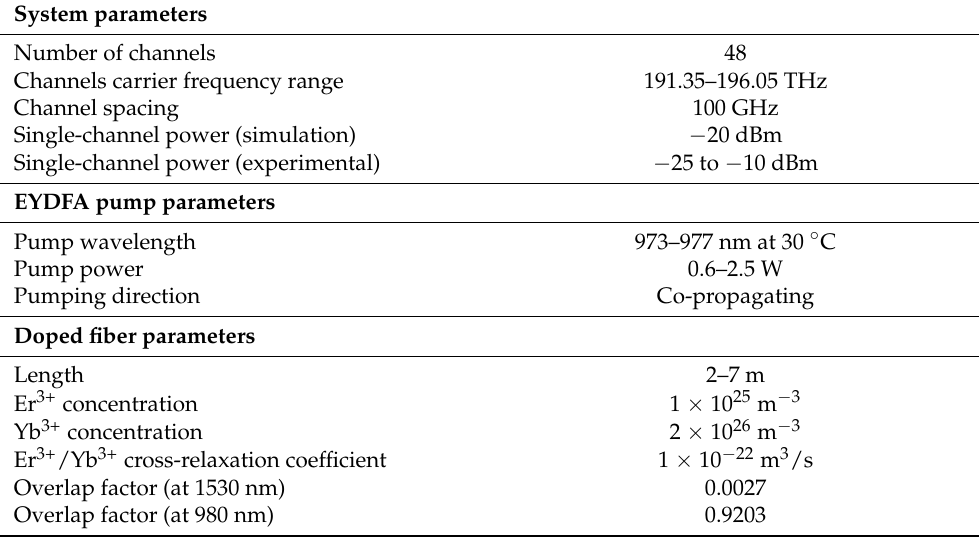
Figure 6. Simplified experimental setup of the cladding-pumped EYDFA. Amplifier’s optical section is between two clad-pumping fiber couplers. Table 1. Amplifier test setup